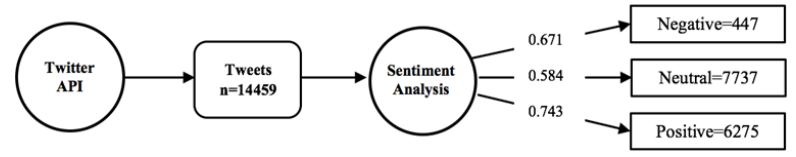
Figure 1. Classification of tweets according to feelings about the environment.